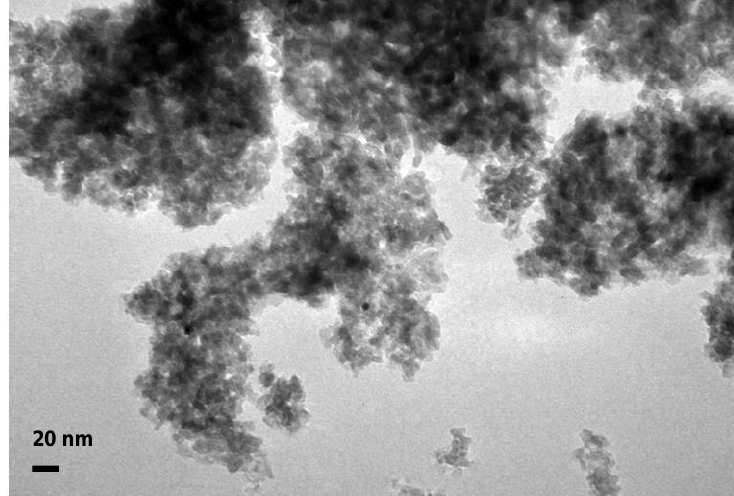
2 O 3 -K(10 wt%) catalyst.